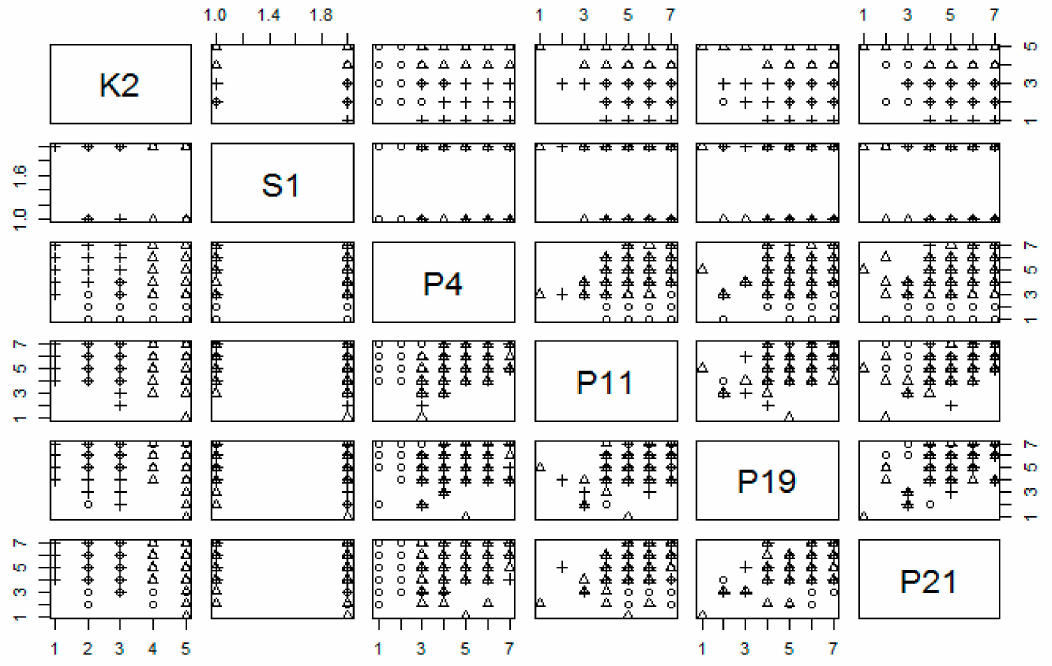
Figure 8. Segmentation of customers of the auto repair shops with the use of cluster analysis. Source: authors’